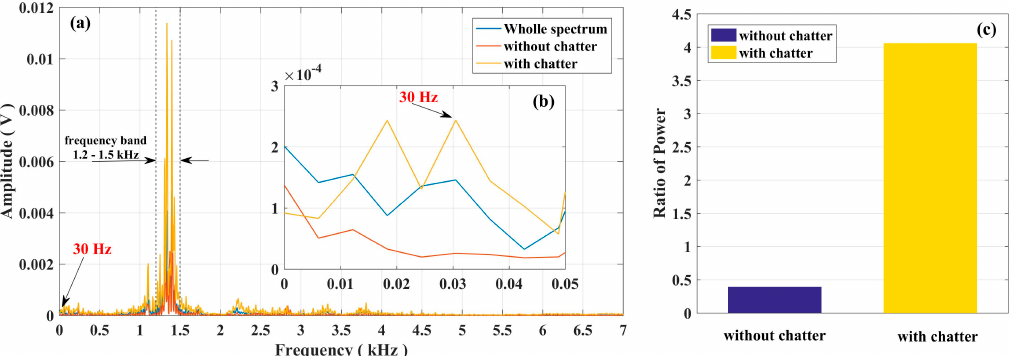
Figure 2. ( a , b ) frequency spectra for the entire grinding pass, section without and with chatter; ( c ) calculation of the ROP statistical parameter for the conditions without and with